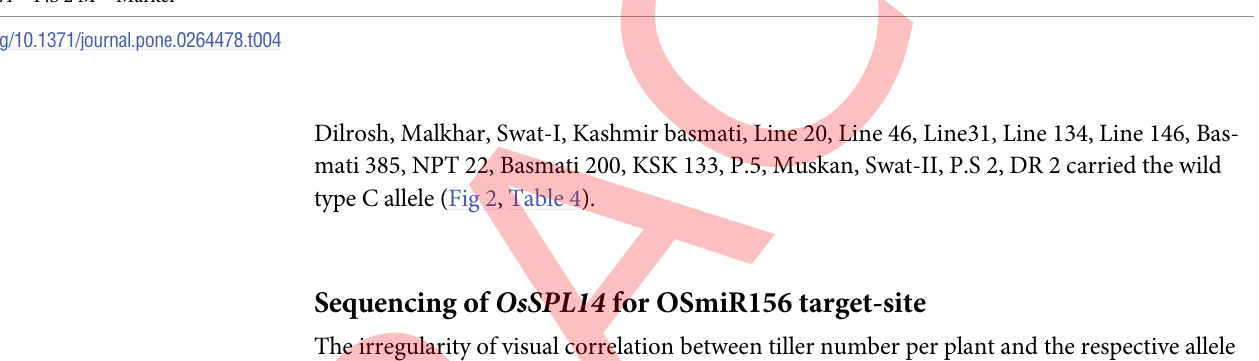
Sequencing of OsSPL14 for OSmiR156 target-site The irregularity of visual correlation between tiller number per plant and the respective allele was sequenced at the 3 rd exon of OsSPL14 gene, which carries OSmiR156 directed transcrip- tional cleavage, if any additional mutation in miRNA target site. Interestingly, the sequence result revealed a new single nucleotide polymorphism (C-T substitution) in 09 different acces- sions, 2bp upstream of the previous reported SNP (C-A) [14, 18] in the target seed sequence for miRNA156 (Fig 3).